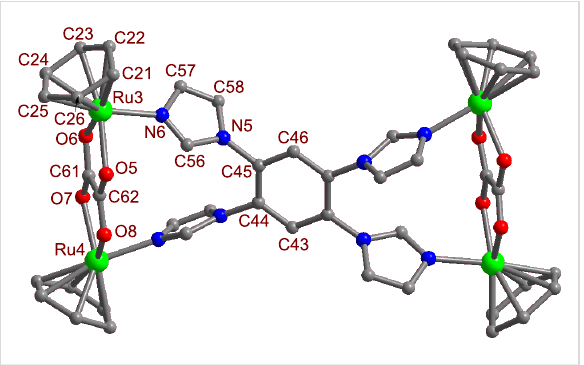
Figure 3: A ball and stick representation of 2a with atom numbering. Color code: Ru = green; O = red; N = blue; C = dark gray. All hydrogen atoms, triflate counter anions, isopropyl and methyl groups of the p -cymene moiety are omitted for the sake of clarity.